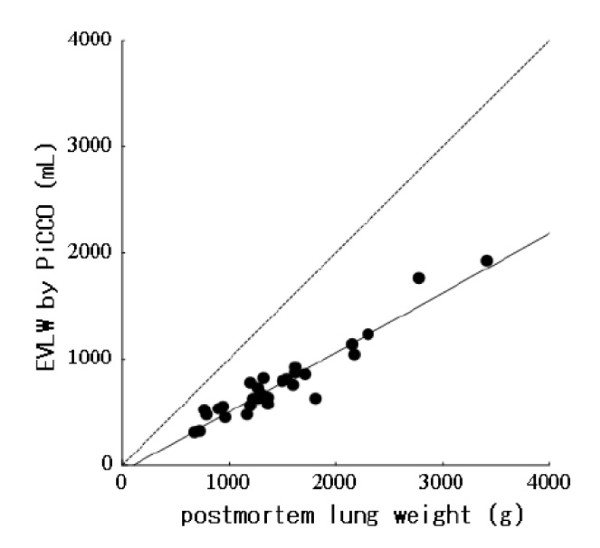
Correlation of extravascular lung water (EVLW) measured by single transpulmonary thermodilution and by postmortem lung weight. EVLW (in milliliters) = [0.56 × lung weight (in grams)] - 58.0. n = 30, r = 0.90, P < 0.001. Line of identity is dashed.